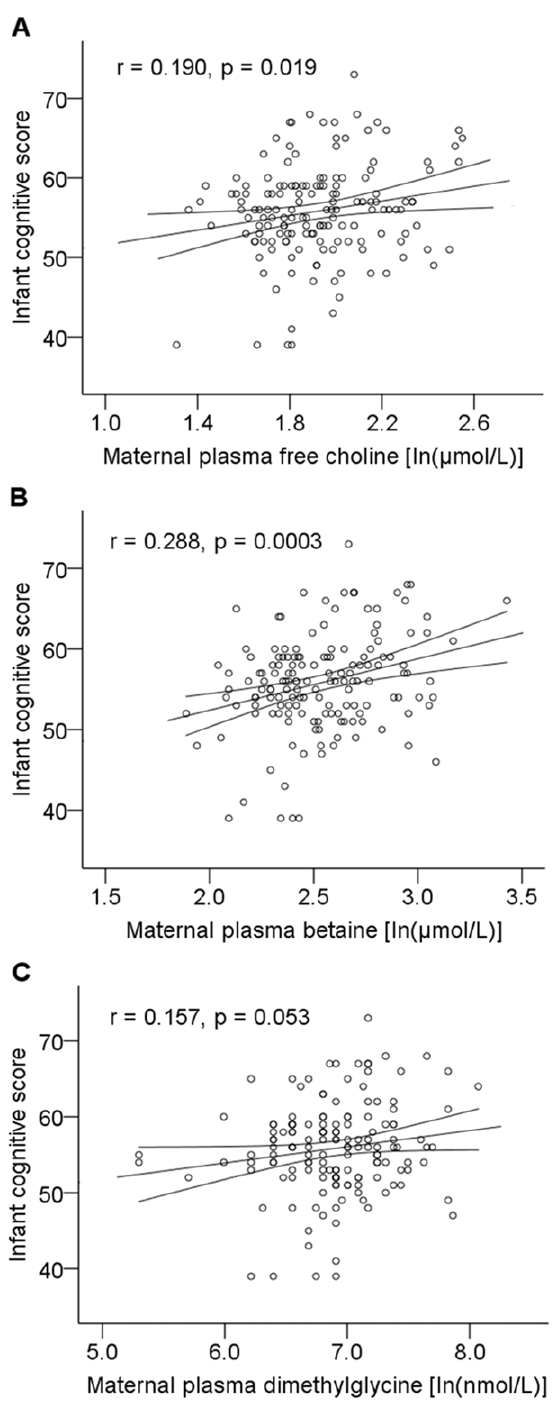
Figure 4. Scatter plots to show the relationship between infant cognitive scores and maternal plasma choline metabolites. Plasma metabolite concentrations were normalized by a single natural log transformation (A, B and C). Infant cognitive development was assessed using the Bayley Scales of Infant Development III. The antilog of the natural log is equivalent to the exponential of the natural log value, that is 2.718 to the exponential of the value plotted on the x axis or e x . The results were analysed for 154 mother-infant pairs using Pearson correlation analysis, A. choline r=0.190, p=0.019, B. betaine r=0.288, p=0.0003, C. dimethylglycine, r=0.157,